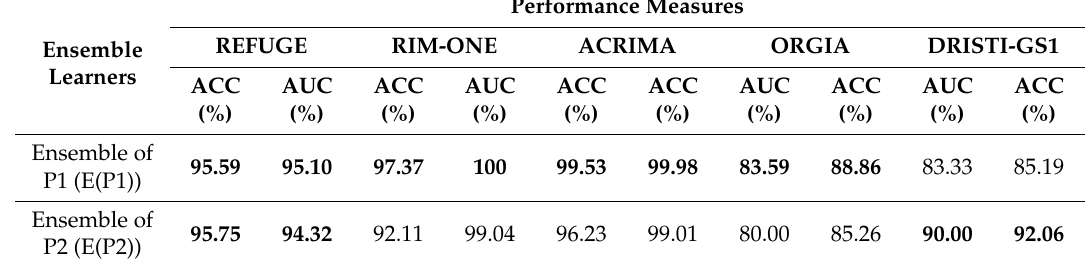
Table 7. P3: Ensemble of methods in P1 and P2 for glaucoma classification.